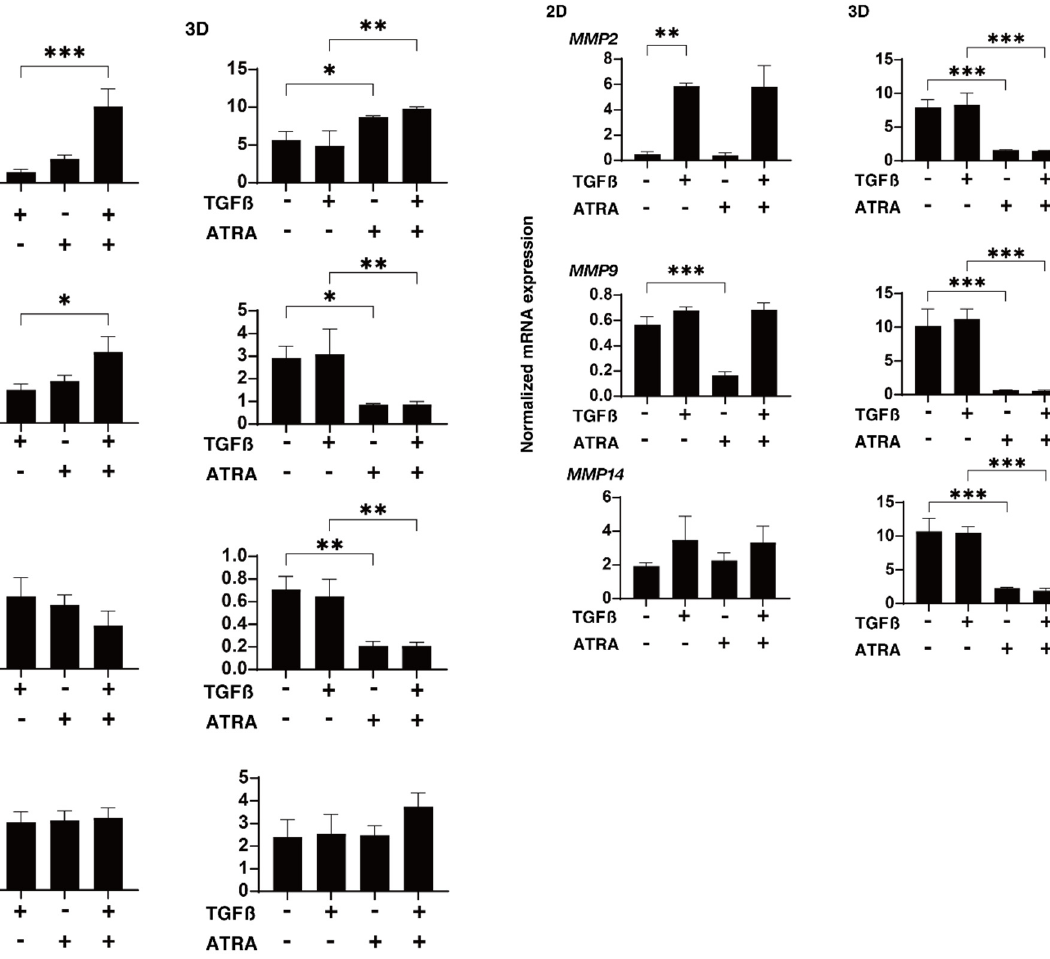
Figure 5. Effects of ATRA on the mRNA expression of TIMPs and MMPs in TGF- β 2-treated 2D- and 3D-cultured HTM cells. Two- and three-dimensionally cultured HTM cells untreated (NT; nontreated control) or treated with 5 ng/mL TGF- β 2 (TGF β ) and/or ATRA (10 µ M) in the absence or presence of 10 µ M ATRA were subjected to qPCR analysis to estimate the expression of mRNA in TIMP1–4 , and MMP 2, 9, and 14 . All experiments were performed in triplicate each using freshly prepared 2D HTM cells and 3D HTM spheroids ( n = 15–20, total 45–60) in each experimental condition. Data are presented as the mean ± SEM. * p < 0.05, ** p < 0.01, *** p < 0.005; ANOVA followed by a Tukey’s multiple comparison test.